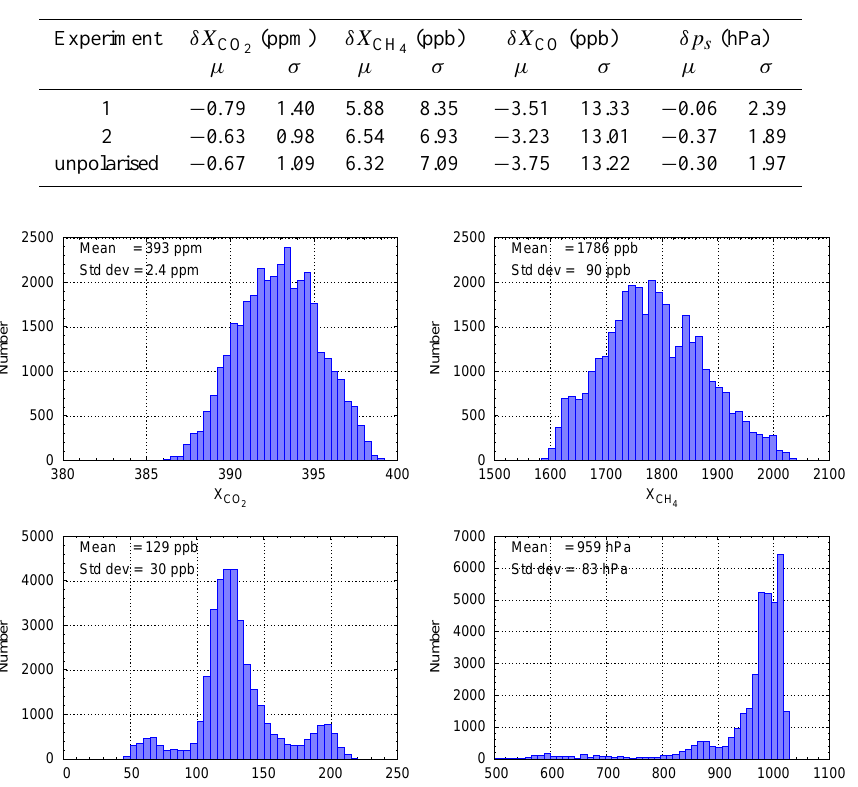
Figure 7. Histograms of X CO , X CH , X CO and surface pressure for the ensemble of soundings in the simulation. The surface pressure 2 4 histogram covers a wide range because the frame passing through Agra includes the